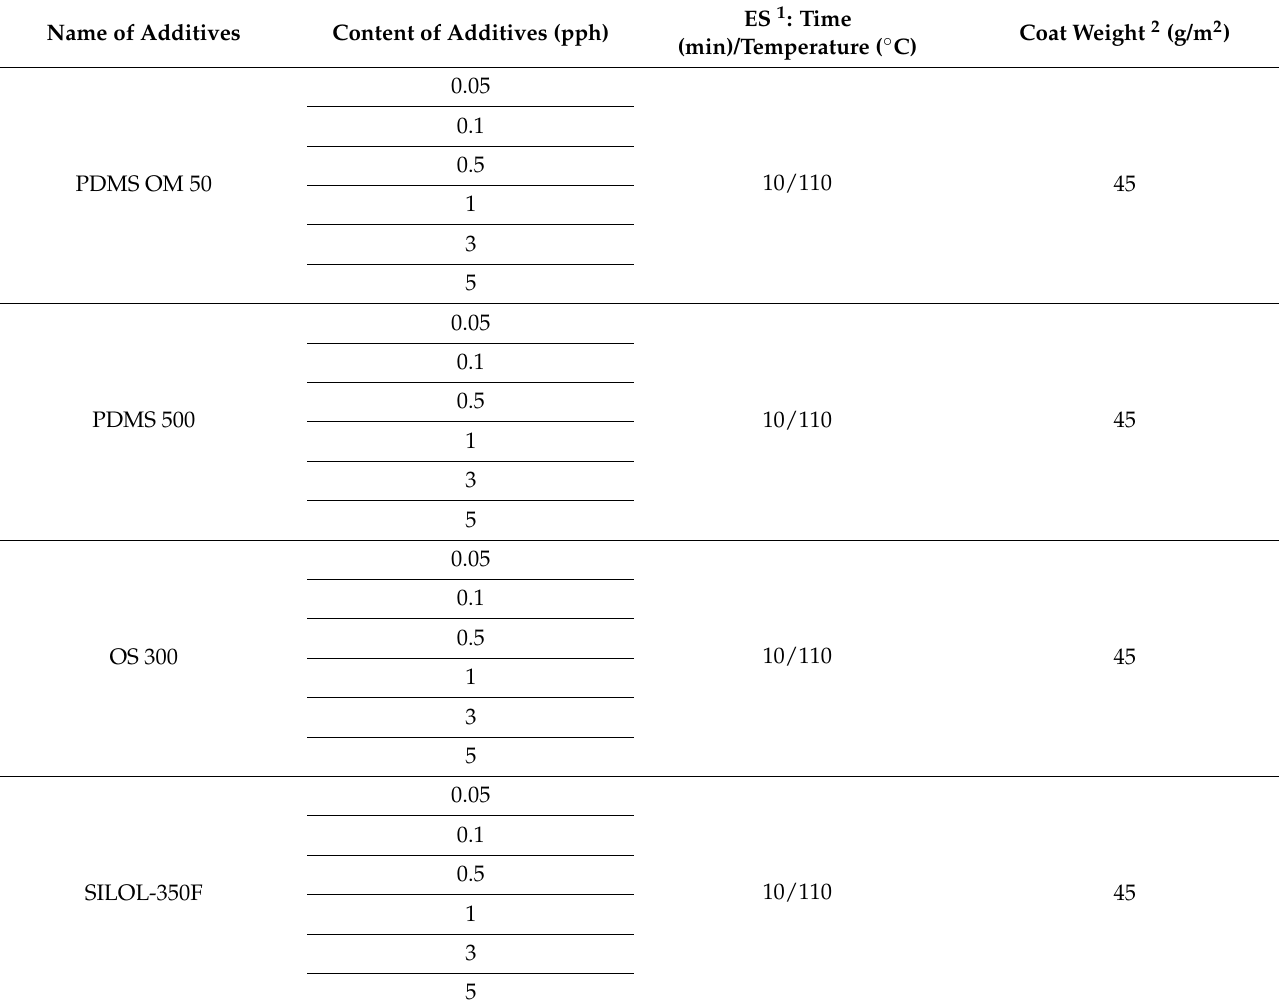
Table 2. The conditions of preparation of adhesives and adhesive